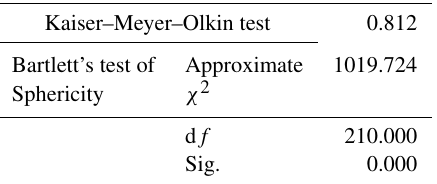
Table 3. Results of KMO and Bartlett’s test of sphericity. Sig. de- notes